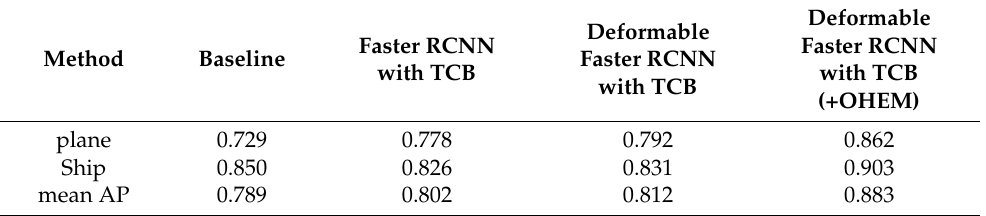
Table 2. The results of modified Faster R-CNN on SORSI